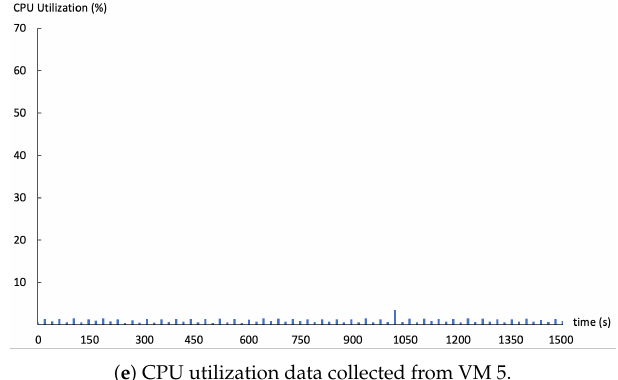
Figure 2. CPU utilization data collected from five VMs, named VM 1 to VM